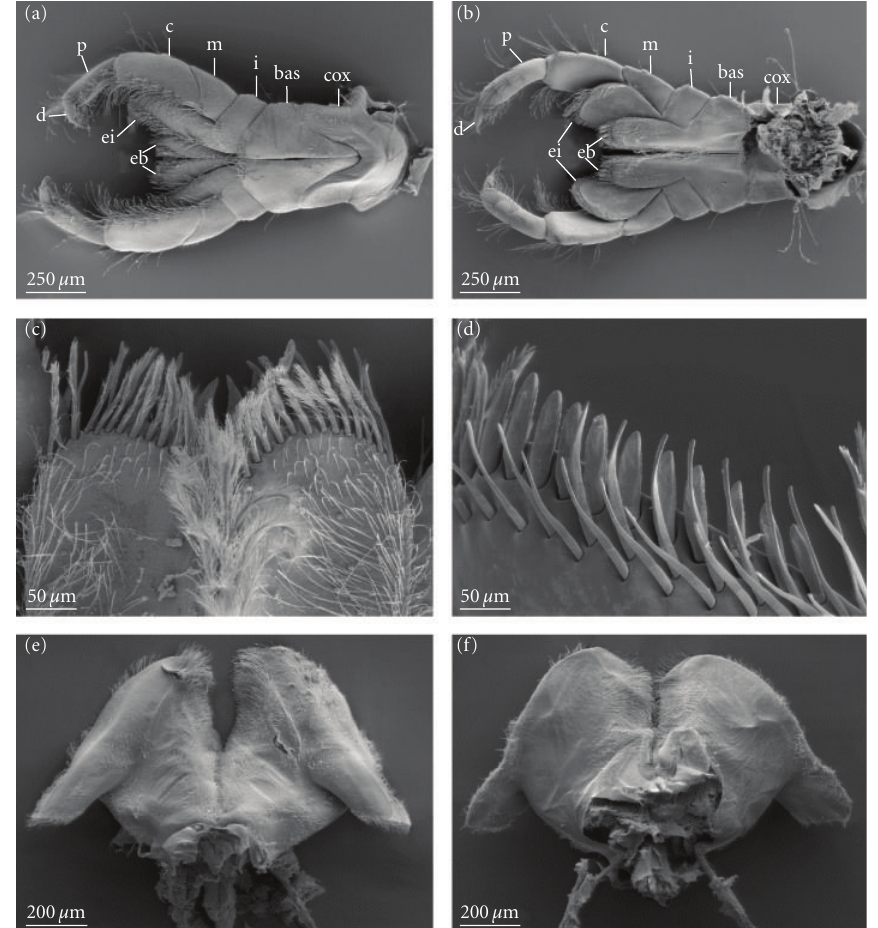
Figure 6: SEM images of maxillipeds and paragnaths of Gammarus fossarum : (a) maxillipeds in posterior view; (b) maxillipeds in anterior view; (c) distal setation of endite of left basipod in anterior view (cf. eb in (b)); (d) median setation of endite of right ischium in posterior view (cf. ei in (a)); (e) paragnaths in posterior view; (f) paragnaths in anterior